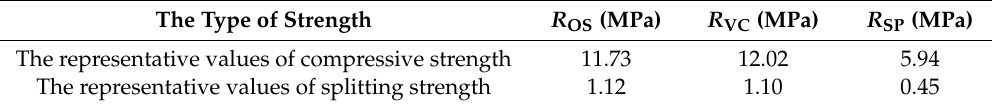
Table 9. 7d mechanical strength between on-site sample and indoor molded